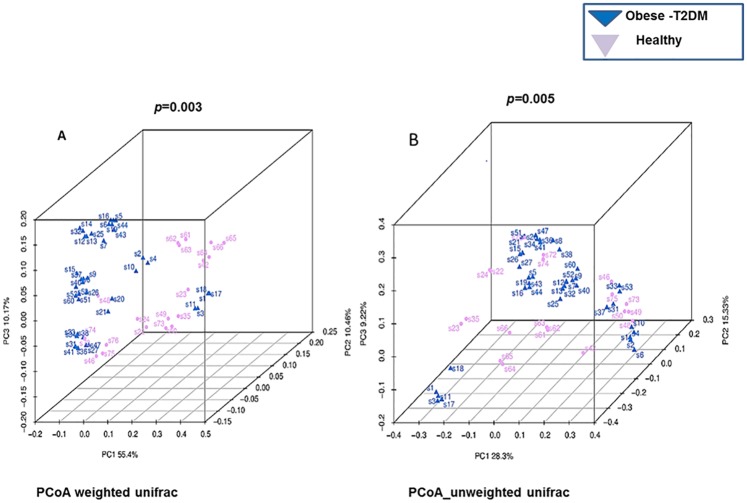
Beta-diversity of the gut microbial communities in obese-T2DM patients and healthy participants.Principal Coordinates Analysis (PCoA) plot based on weighted and unweighted UniFrac distance. Each dot represents one sample from each group.